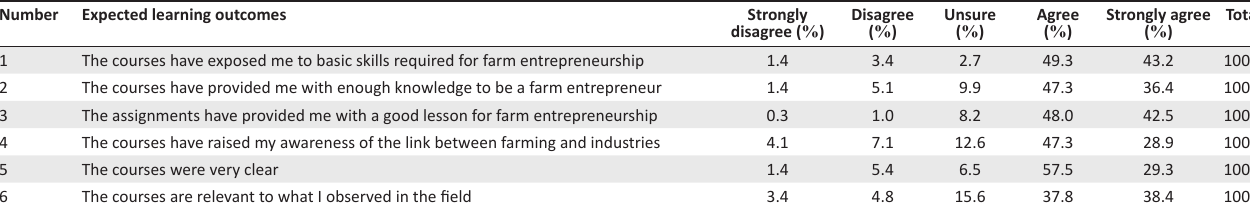
TABLE 5: Perception of expected learning outcomes in relation to farm entrepreneurship. Number Expected learning